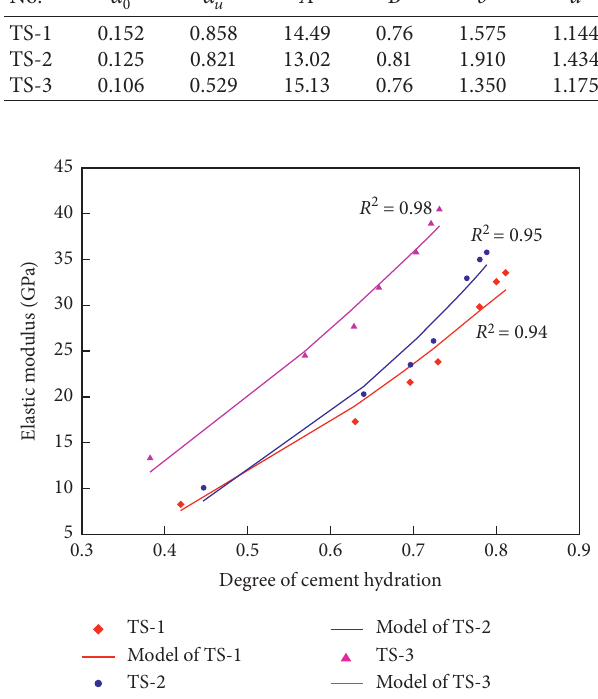
Figure 4: Test and fitting values of concrete elastic modulus and hydration degree of TS-1 concrete, TS-2 concrete, and TS-3 concrete.